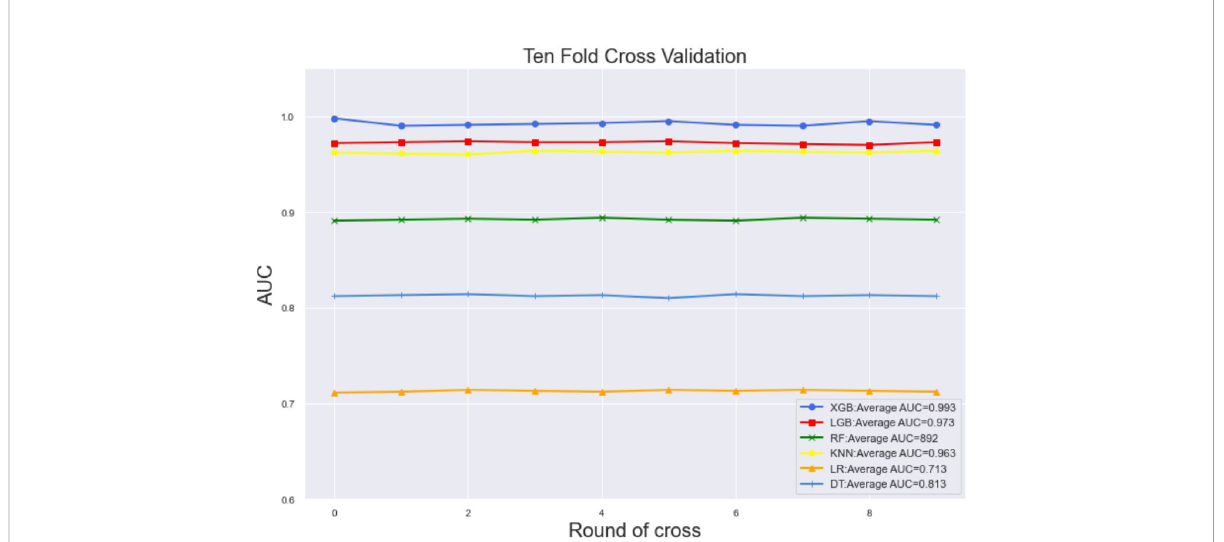
FIGURE 4 The training set has ten-fold cross-validation results of different machine learning models. Abbreviations: LGBM, light gradient boosting; XGB, extreme gradient boosting; RF, random forest; LR, logistic regression; KNN, K-nearest neighbor; MLP, multilayer perceptron.